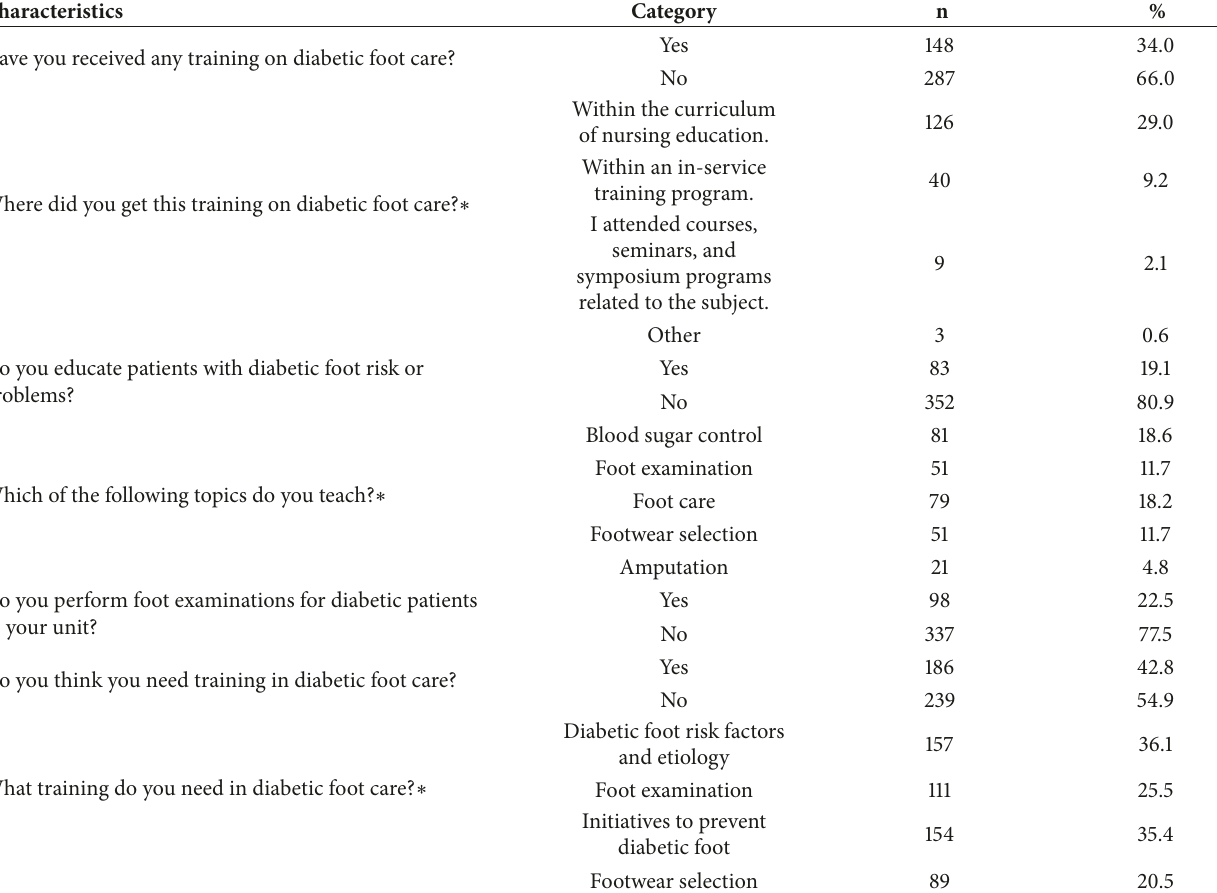
Table 2: Distribution of nurses according to characteristics related to diabetic foot management care. Characteristics